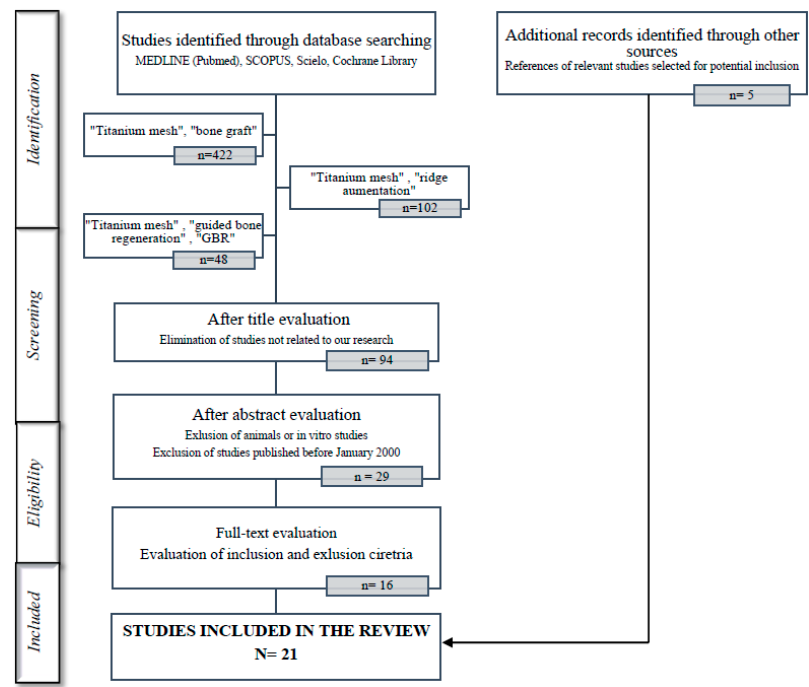
Figure 2. Flow diagram of study inclusion.